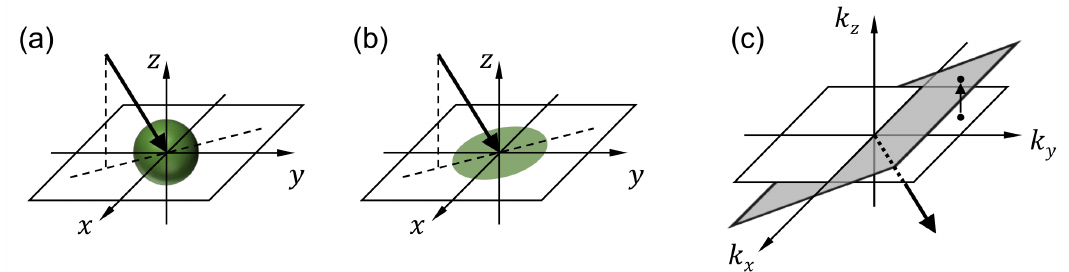
Figure 3. Snapshot projection optical tomography (SPOT) data processing. For each wavelength, the 3D distribution of fluorescence light within the specimen is calculated using the deconvolution and inverse projection operations described in the Methods section. ( a , b ) illustrate the projection operation performed by each lenslet in the micro-lens array, and ( c ) shows the inverse projection operation performed in the reconstruction. ( x , y , z ) are the Cartesian coordinates with z being the optical axis direction. ( k x , k y , k z ) are the spatial frequency components corresponding to ( x , y , z ) ,